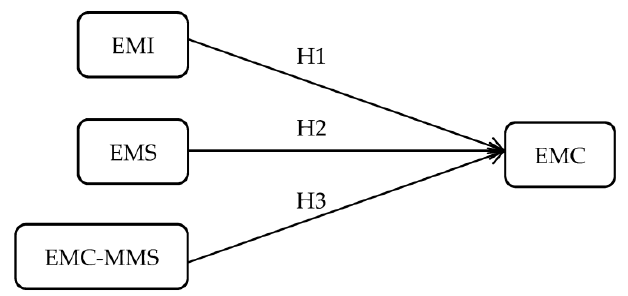
Figure 1. Research model. Source: author’s elaboration.